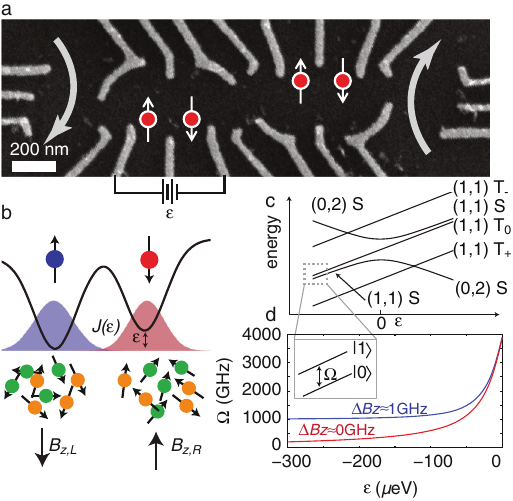
Fig. 1 Experimental set-up. a Scanning electron micrograph of a two-qubit device identical to the one used in this work. Red circles indicate approximate positions of electrons in the double-well potentials created by metal depletion gates ( gray ). Arrows indicate the positions of sensor quantum dots. A voltage difference ε applied to plunger gates adjusts the exchange interaction. b The gate- contolled wavefunction overlap between electron spins produces Fig. 2 Single-qubit operations. a Time-varying voltage pulses the exchange interaction J ( ε ). Each electron also interacts with a resonant with the qubit splitting induce Rabi oscillations. b large number of Ga and As nuclear spins ( green and orange circles) Coherence times of driven Rabi oscillations ( blue ) and rotary echo via the hyper fi ne interaction, leading to a difference in the ( red ) vs. Rabi drive strength. The solid blue line is a theoretical curve longitudinal magnetic gradient between the dots Δ B z = B z,L − B z,R . c taking into account the measured charge and hyper fi ne noise levels Energy level diagram showing the two-electron spin states of a in our qubit. The data agree with the model. The dashed red line double quantum dot. We operate the qubit with ε < 0 and J ( ε ) ≪ Δ B z , between data points is a guide to the eye. At low drive strengths, as indicated with the dashed gray box. d Calculated qubit energy hyper fi ne fl uctuations limit the coherence time, and at large drive splitting J ( ε ) for the two cases when Δ B z = 0 and Δ B z ≈ 1 GHz. When strengths, charge-noise-induced fl uctuations in the Rabi frequency ε and is Δ B limit the coherence. c Randomized benchmarking yields an average z is large, the qubit splitting does not depend on insensitive to electric fi elds gate fi delity of 98.6 ± 0.2%. Error bars are statistical uncertainties. Note that the qubit splitting points along the x direction, and all gates are performed with phase-modulated rf pulses. See Supple- mentary Information for more details on randomized